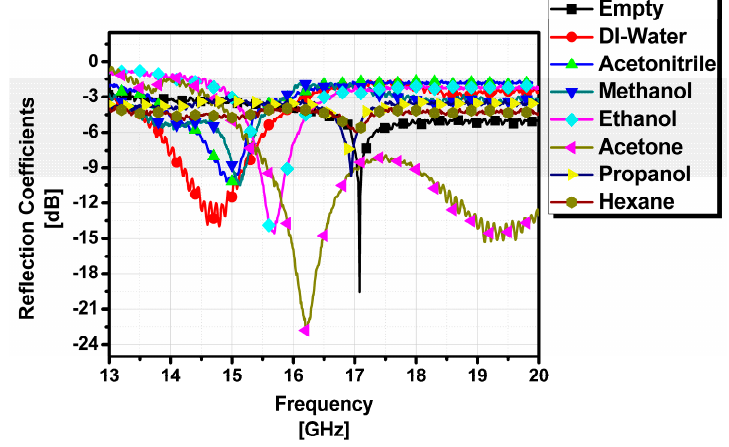
Figure 7. Measured reflection coefficients.